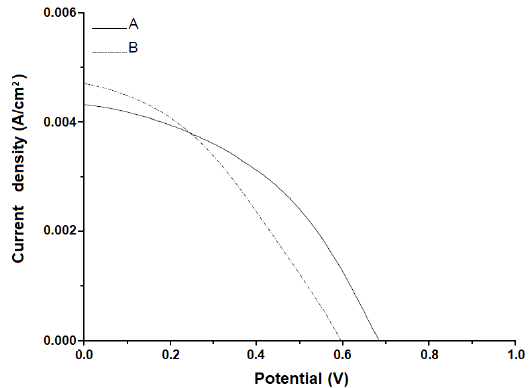
Figure 11. j x V curve for cells with (A) and without (B) 4-tert- butylpyridine (0.05 M). Electrolyte: NaI (0.5 M) / I2 (0.05M). Other conditions: FTO; counter- electrode: graphite paste; Photoanode: TiO